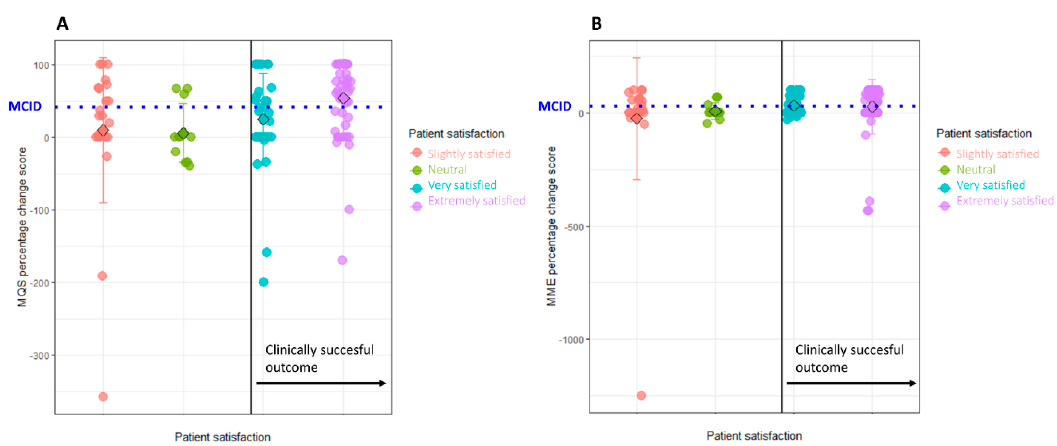
Table 1. Distribution- and anchor-based proposed MCID values for the MQS and MME in patients with FBSS after treatment with high-dose spinal cord stimulation (HD-SCS).